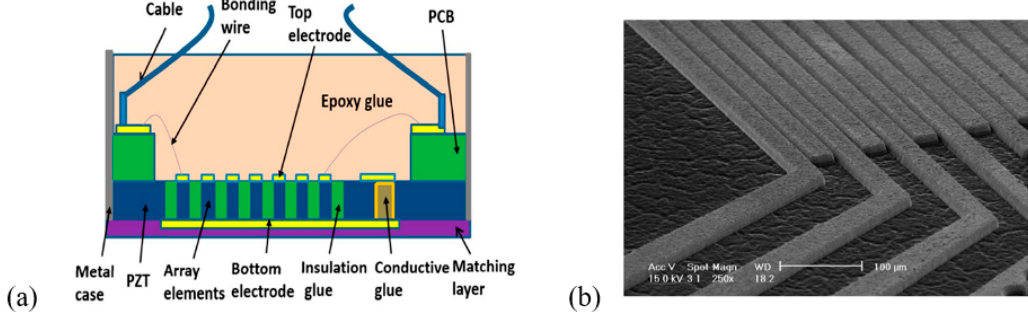
Figure 7. ( a ) Schematic of a PZT-based linear pMUT array (Reproduced with permission from MDPI [94]). ( b ) SEM image of a linear array dry-etched from a PZT composite film (Reproduced with permission from IEEE [93]).